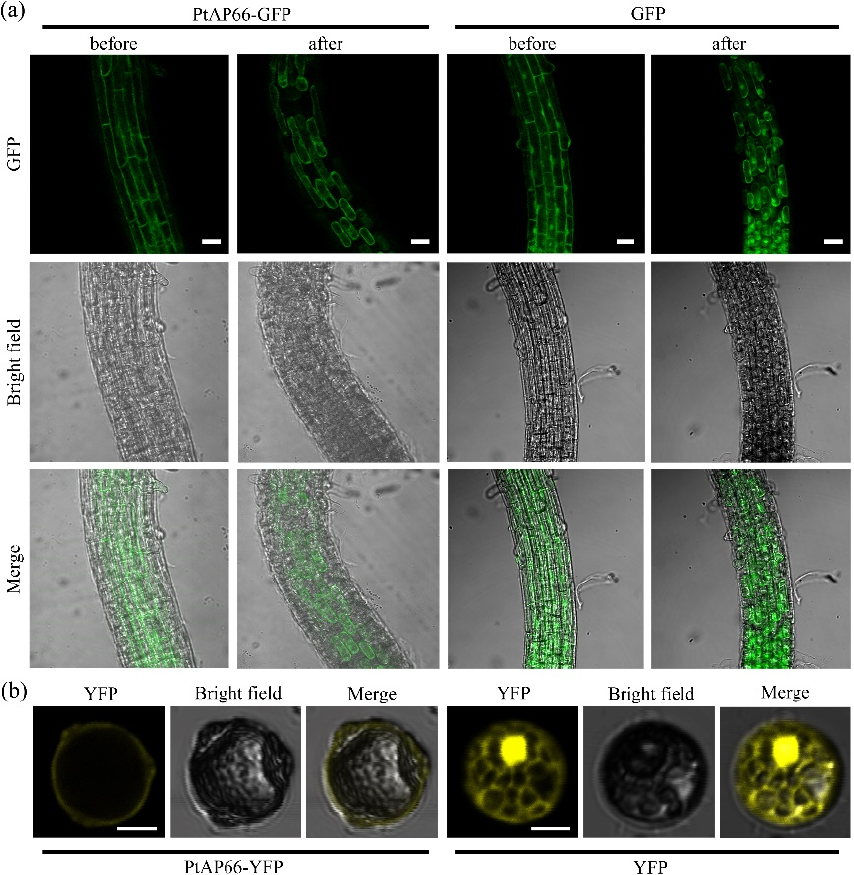
Figure 2. Subcellular localisation of the PtAP66-fused fluorescent protein in Arabidopsis root cells and Populus leaf protoplasts. ( a ) Stable expression of the PtAP66-GFP fusion protein in Arabidopsis root cells; and expression of GFP protein as a control. After 1 M mannitol treatments for 5 min, the GFP fluorescence signals were recorded again. Top panels, GFP fluorescence images; middle panels, bright-field images; and bottom panels, merged bright-field and GFP fluorescence images. Bar = 30 μ m. ( b ) Subcellular localisation of the PtAP66-YFP fusion protein after transient transformation in Populus leaf protoplasts. The expression of YFP protein was used as a control. Bar = 10 μ m.